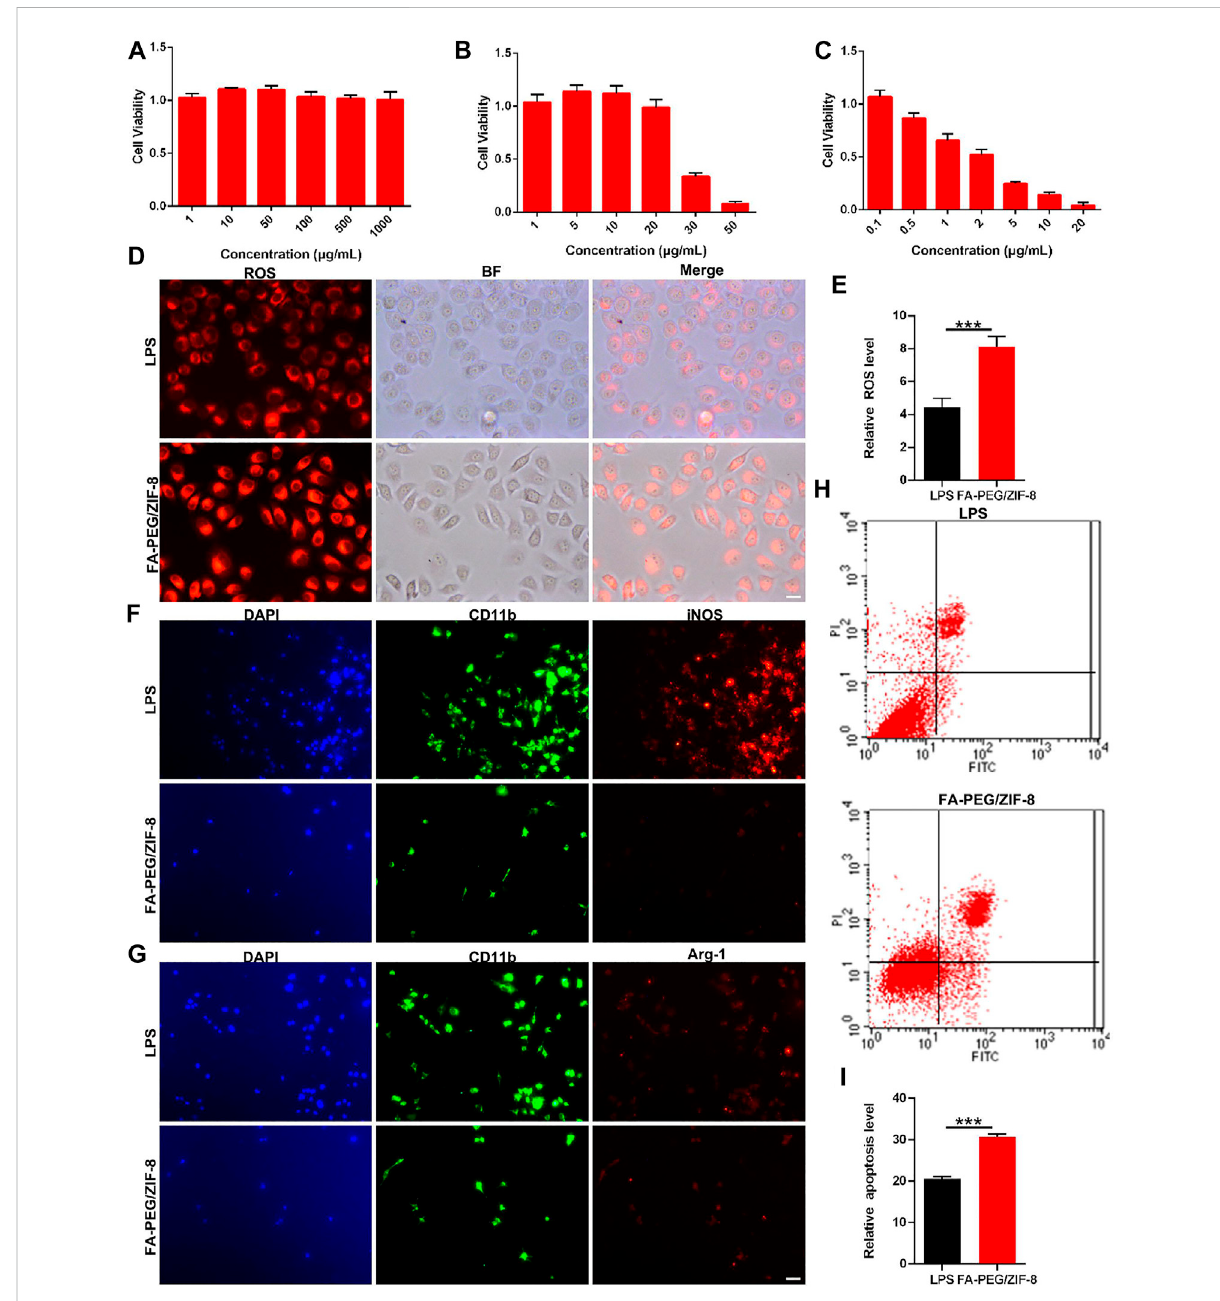
FIGURE 2 Thecellviabilityandanti-in fl ammationeffectofFA-PEG/ZIF-8 invitro .Quanti fi cationanalysisofcellviabilityinRAW264.7cellstreatedwithZIF- 8 (A) , FA-PEG (B) , and FA-PEG/ZIF-8 (C) . Representative images and (D) quanti fi cation analysis (E) of ROS activity in RAW264.7 cells. Scale bars = 50 µm. Representative images of iNOS (F) and Arg-1 (G) in RAW264.7 cells via immuno fl uorescence analysis. Scale bar = 50 μ m. Representative images (H) and semiquantitative analysis (I) . Scale bars, 10 µm. Data presented as the mean±SD. Two-tailed Student ’ s t-test. *** p <